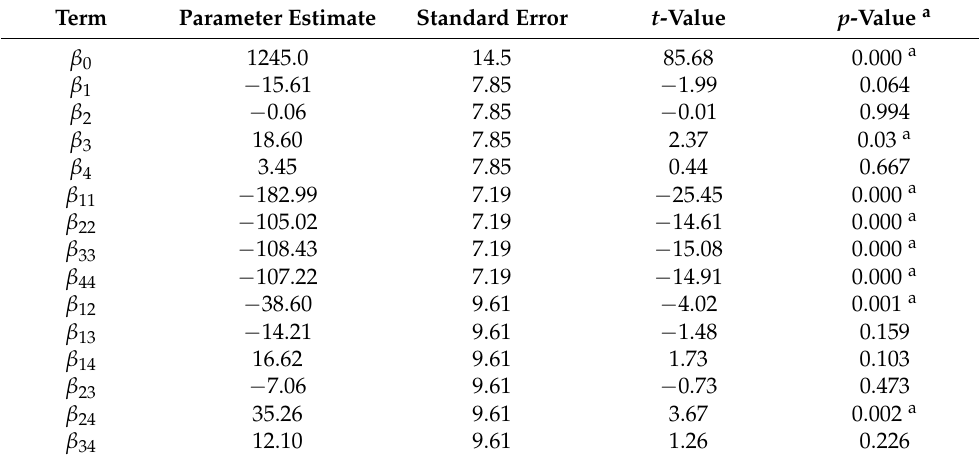
Table 4. Significance of the model